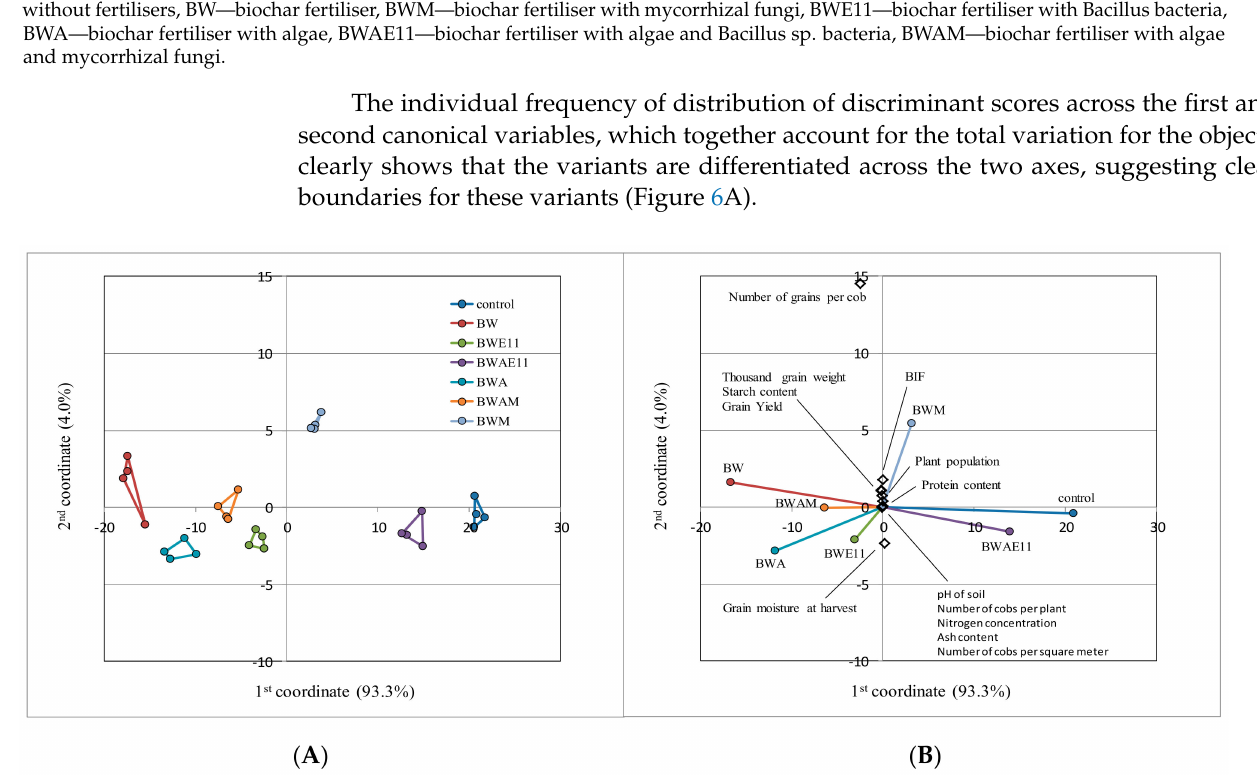
Figure 6. The canonical variate analysis showing the relationship between the experimental variants and the variables describing them (( A )—based on transformation by linear combination; ( B )—based on singular value